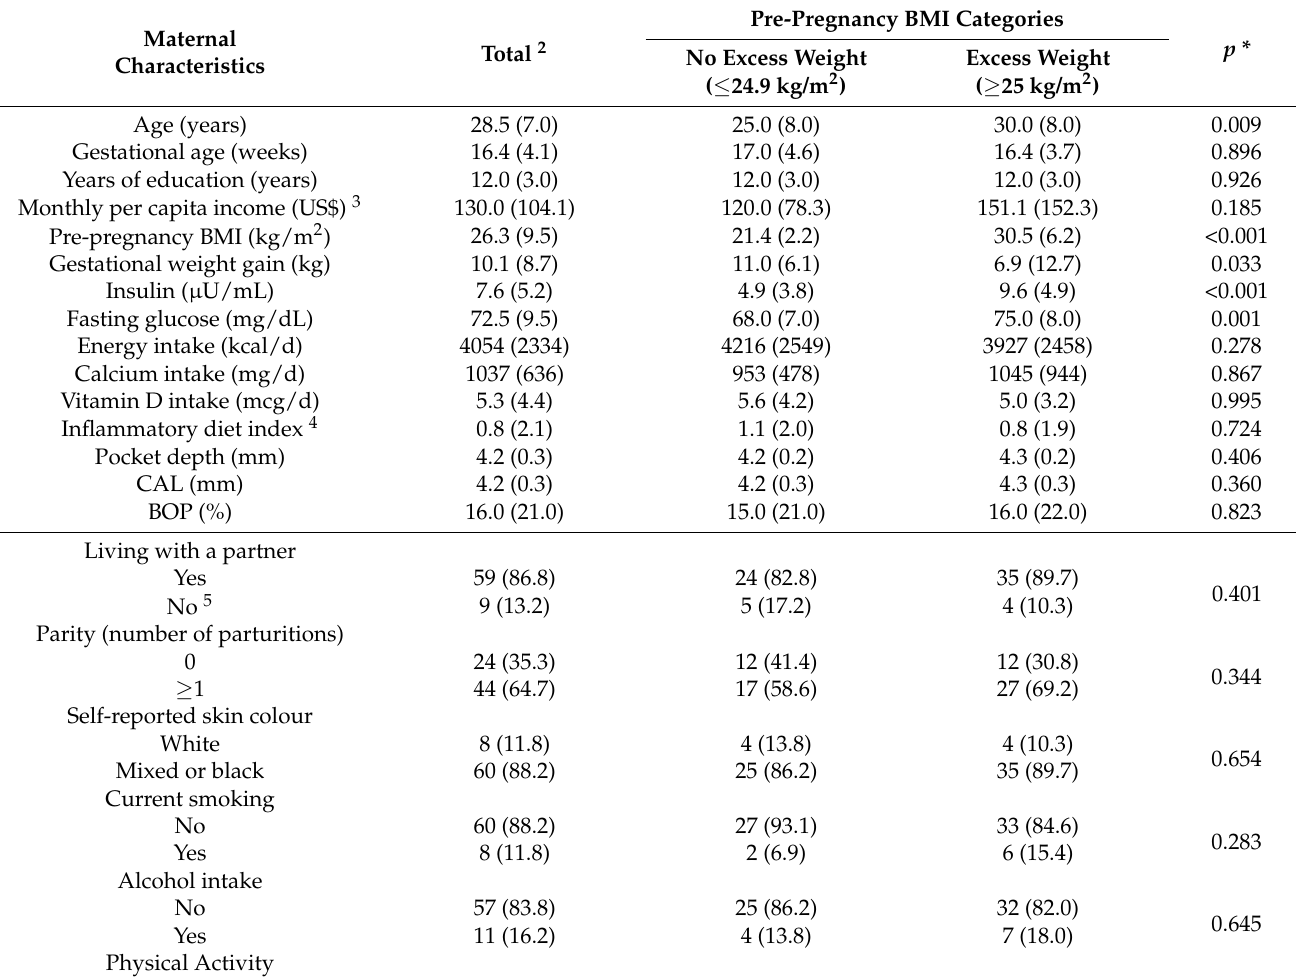
Table 1. Baseline 1 characteristics of pregnant women with periodontitis according to pre-pregnancy BMI